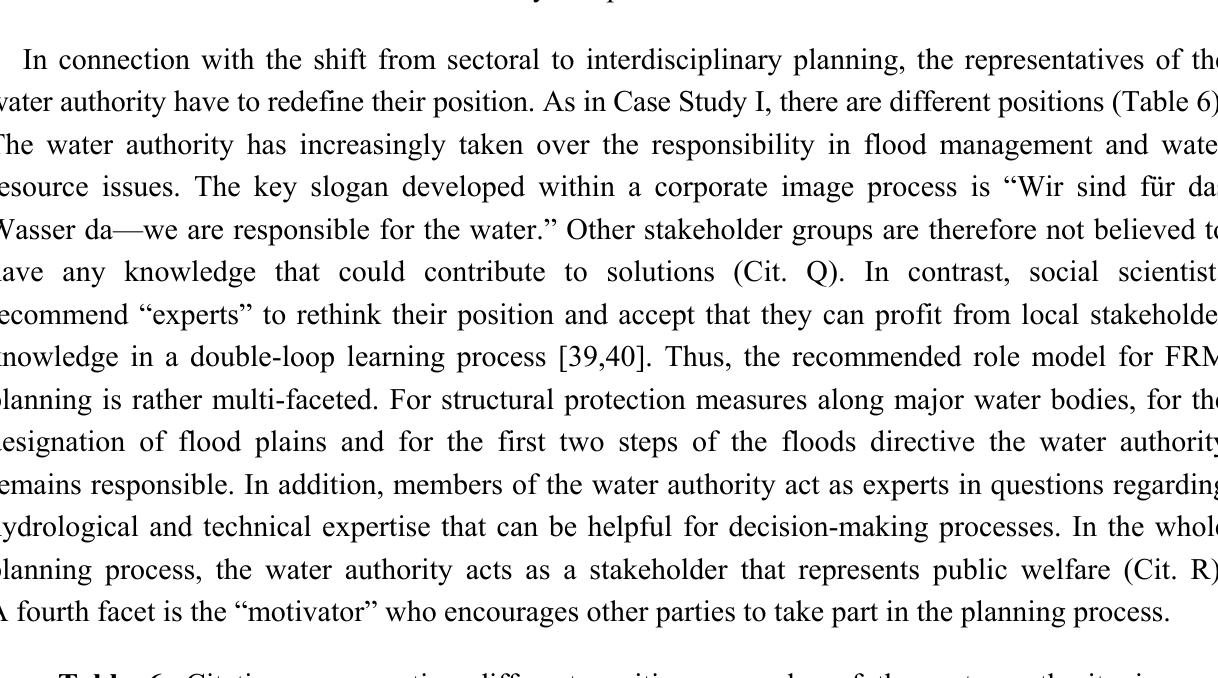
Table 6. Citations representing different positions on roles of the water authority in FRM